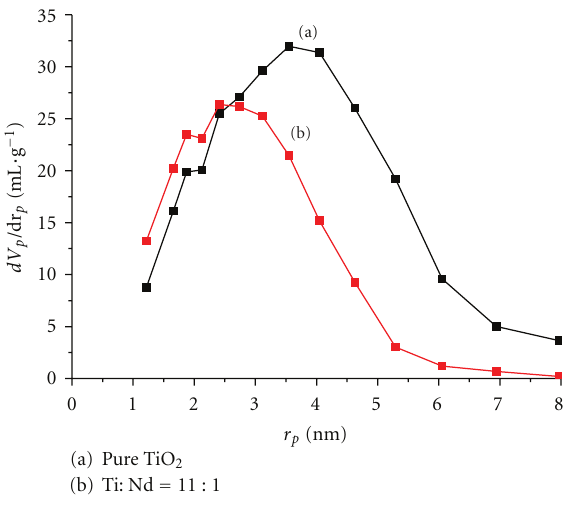
Figure 8: BJH pore size distribution curves for pure TiO 2 (a) and Nd-doped TiO 2 (Ti:Nd = 11:1) (b).